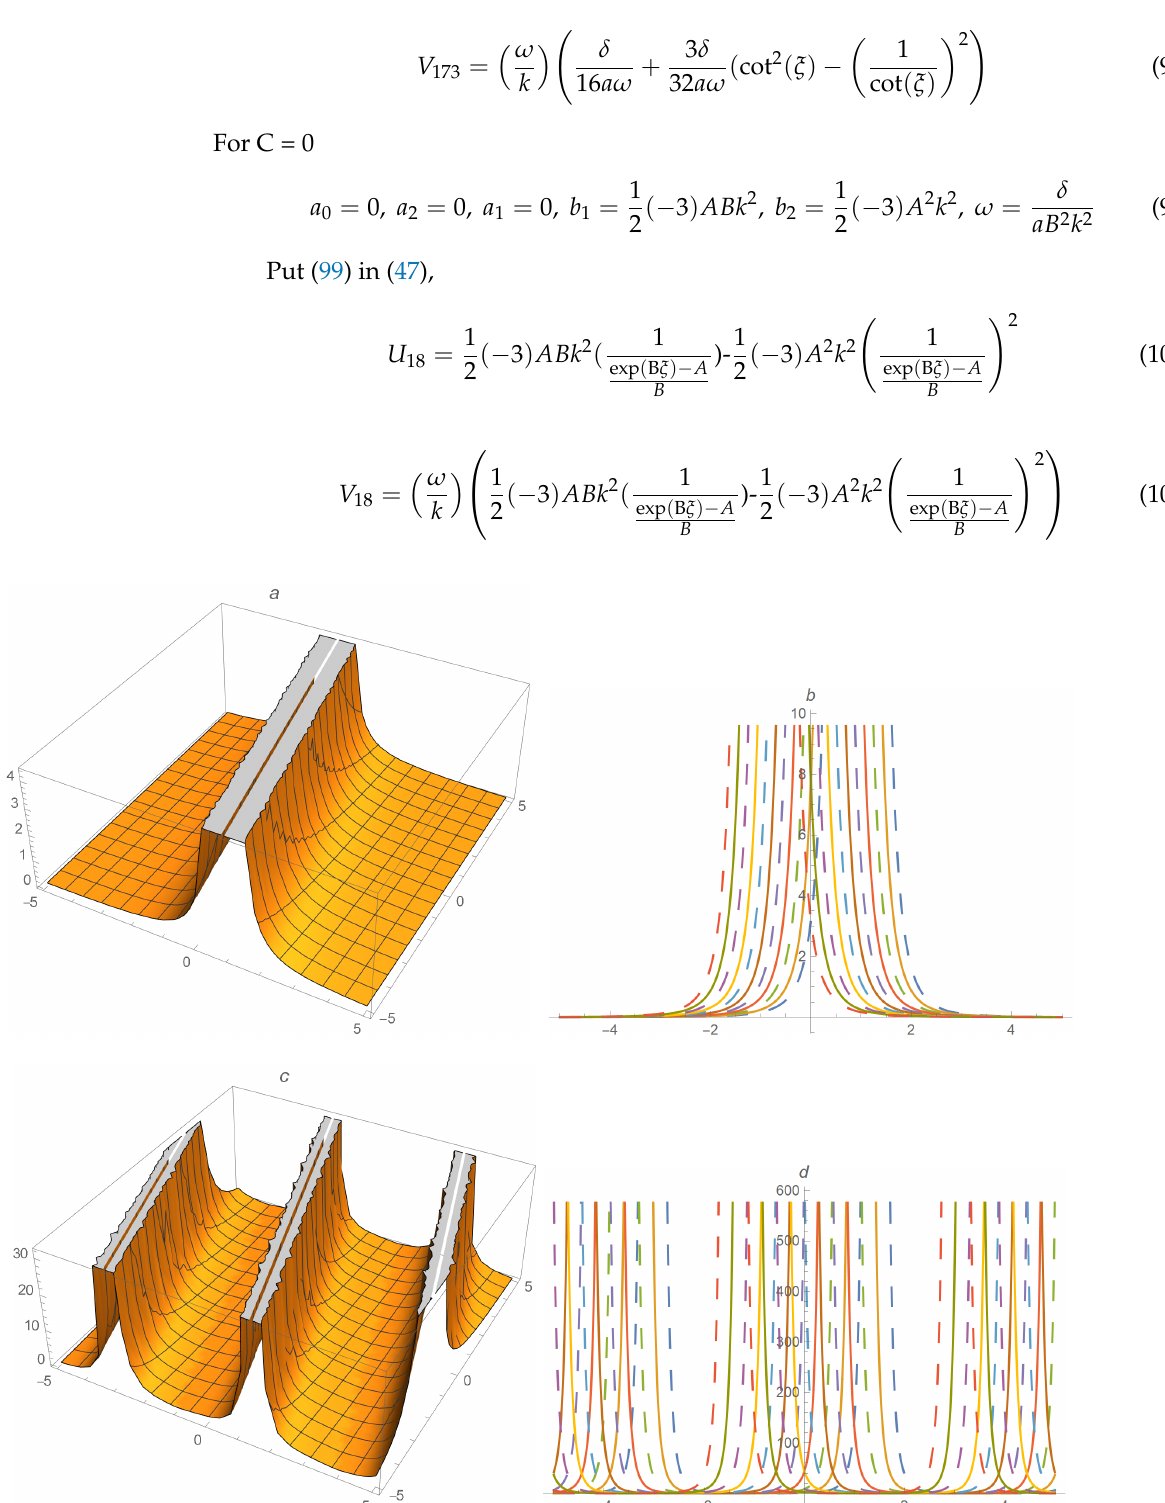
Figure 6. The profile of solutions U 173 ( a , b ) and V 173 ( c , d ) with α = 1, δ = 0.002, a = 2.1, ω = 0.5 and α = 1, δ = 0.1, a = 0.1, ω = 0.5